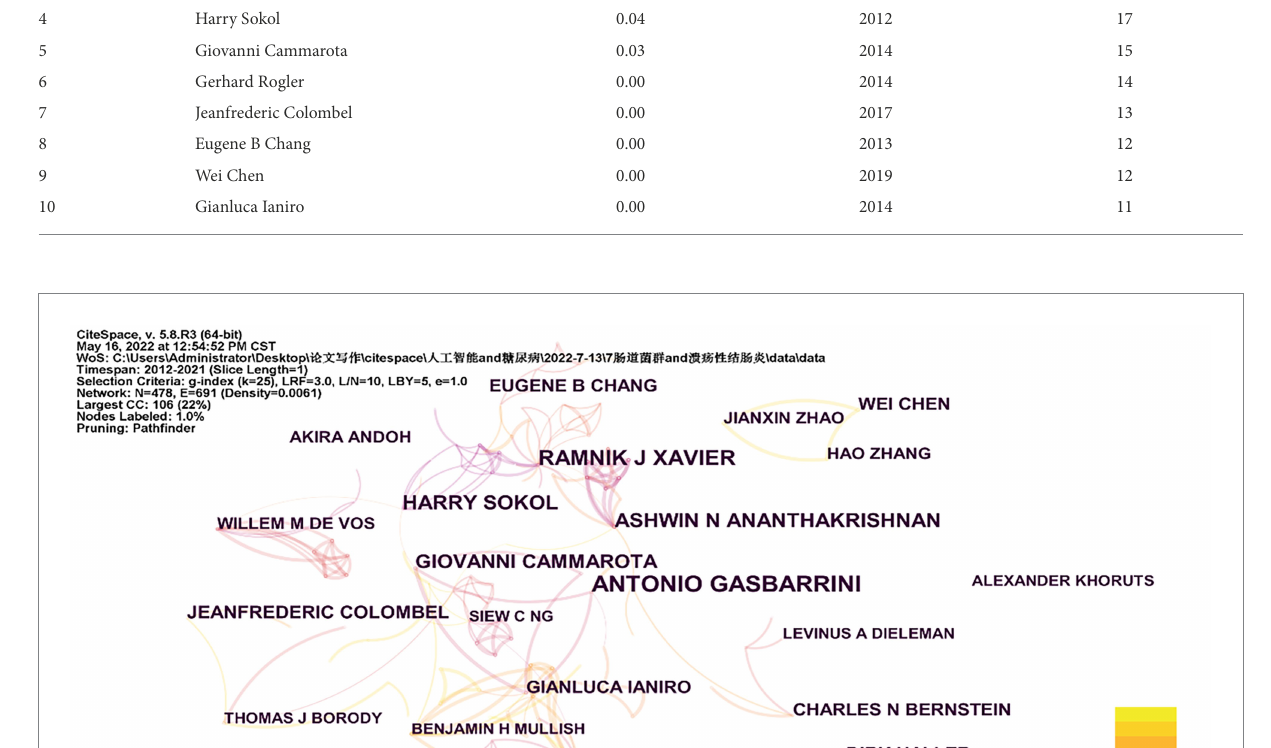
listed in Figure 6. Active ulcerative colitis, insulin sensitivity, and anxiety are a few of the epidemic keywords that started to surface after 2018. Figure 7 shows the relationship between keyword clustering and time. The top ten keyword clusters in the field of intestinal flora and ulcerative colitis research are “#0 th17,” “#1